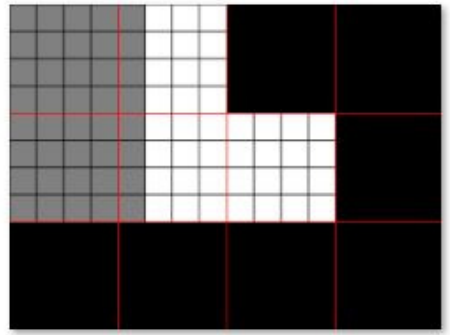
number 7. The average group (1.13) contained 132 cases, with all 10 geometries, where geometry 9 was also the most frequent, with 95 models.